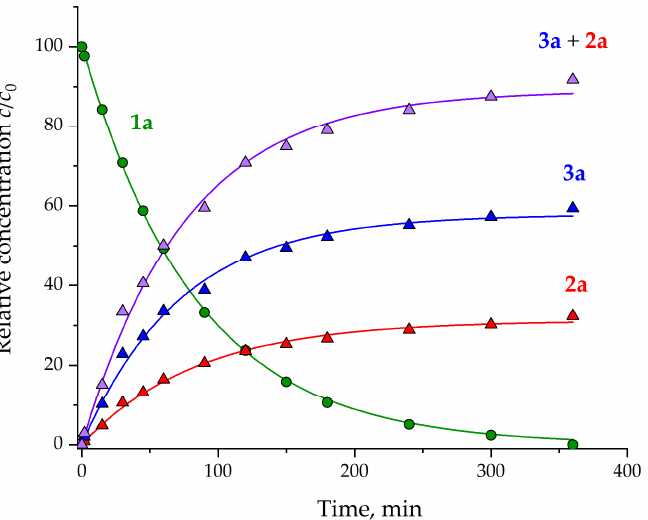
Figure 2. The changes in the composition of 1a → 2a + 3a reaction mixture up to full conversion (green for 1a , red for 2a , blue for 3a and purple for 2a + 3a ).